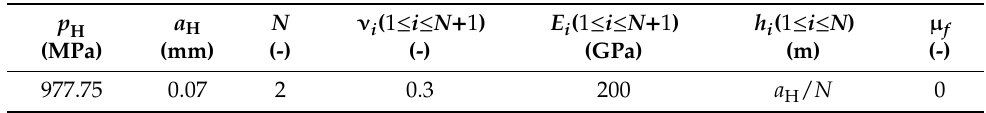
Table 1. Input parameters of the present method for simulating an uncoated half-space of the substrate material subjected to the surface point contact